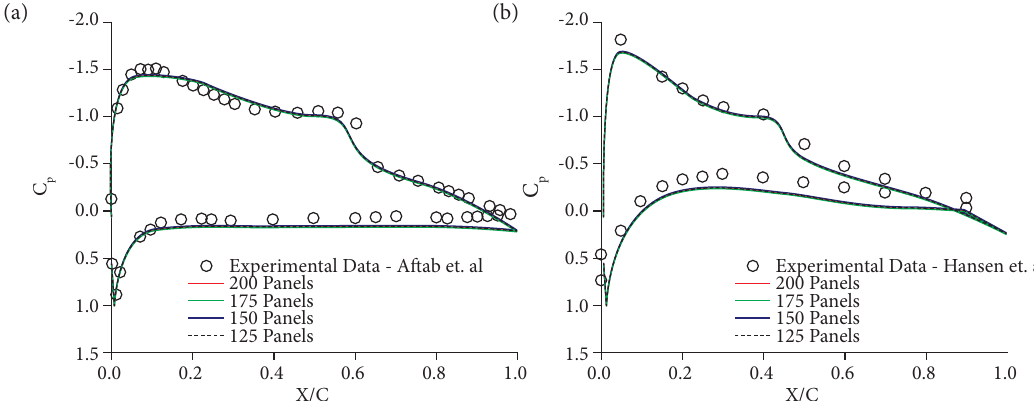
Figure 4. Grid convergence for XFLR5 results: pressure coefficients. (a) NACA 4415 at 6 o AoA; (b) NACA 0021 at 5 o